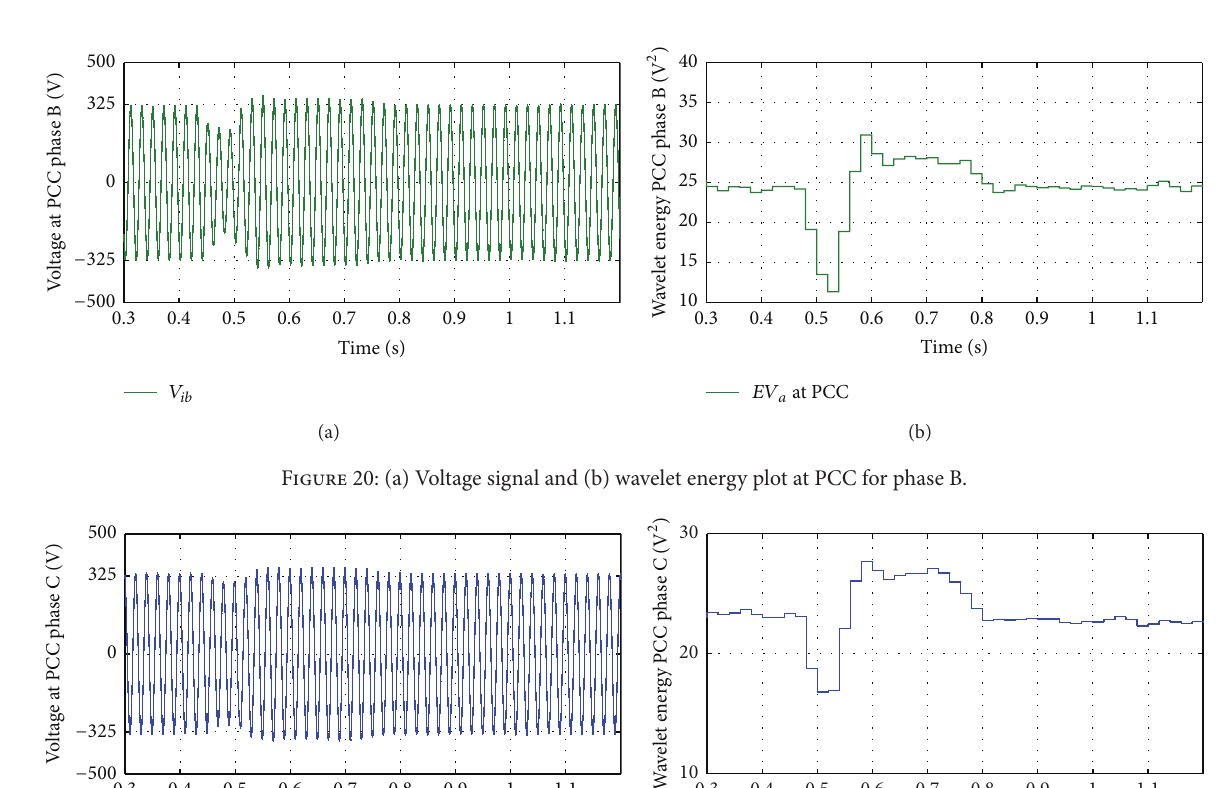
Figure 19: (a) Voltage signal and (b) wavelet energy plot at PCC for phase A.